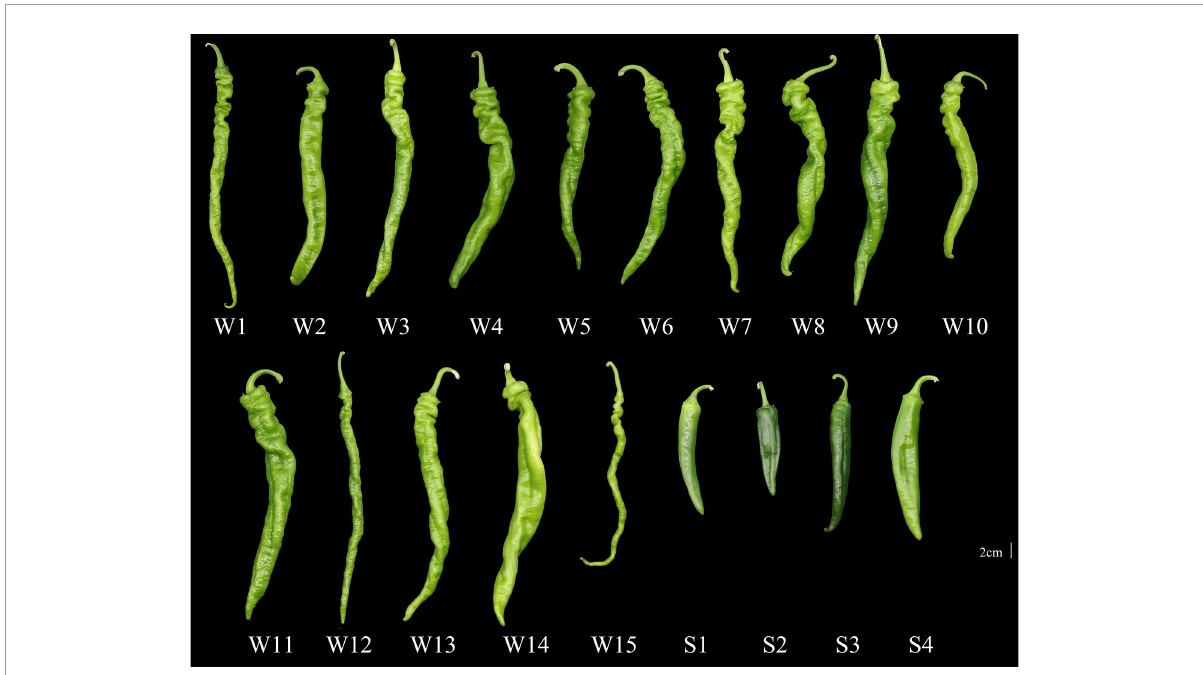
FIGURE1 Pepper varieties used in the present study. W1, Fengshouxianjiao; W2, Sujiao 8; W3, Qingan 7; W4, Sujiao 18; W5, Longjiao 2; W6, Longjiao 10; W7, Longjiao 11; W8, Huamei 105; W9, 37–124; W10, 3F*106; W11, Tianjiao 20; W12, Tianjiao 23; W13, Hangjiao 2; W14, Hangjiao 8; W15, NO.171; S1, NO.212; S2, NO.221; S3, Sujiao 9; S4,